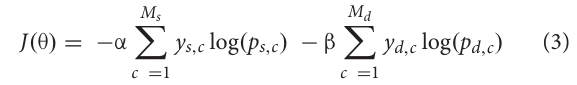
effectively process the temporal dependencies of the sequential data. The outputs of both streams are then concatenated and used to jointly train two different softmax classifiers. One is trained to classify the shape of the VFD ( no loss, central loss, peripheral loss, or hemifield loss ), while the second one was trained to classify the visual field in a point-wise manner (i.e., “does the stimulus position in visual field space coordinates overlap with the